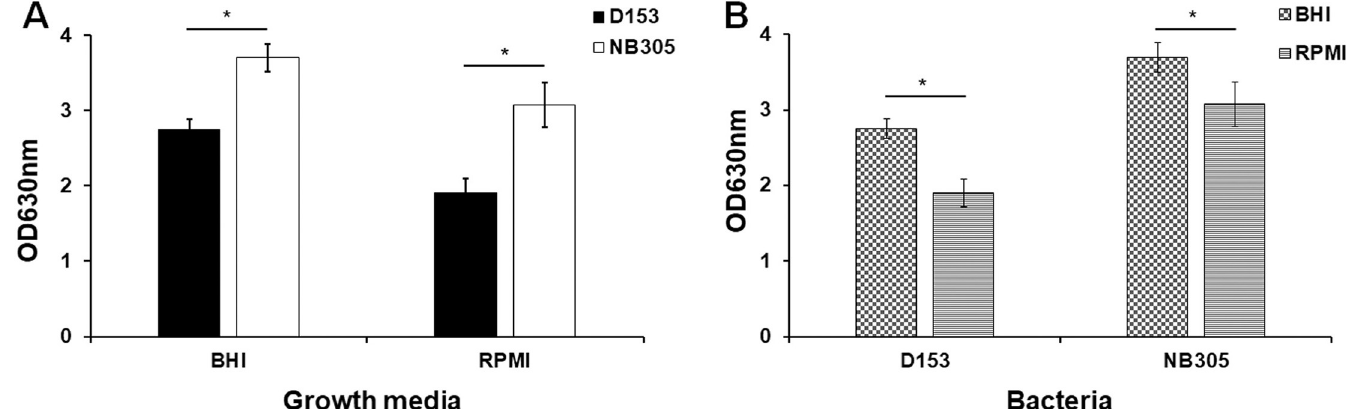
Fig 1. Quantification of total biomass of biofilms. M . haemolytica (D153) and S . aureus Newbould 305 (NB305) were grown in BHI broth and colorless RPMI 1640 in 24-well plates at 37˚C for 48 h (NB305) to 72 h (D153). The effects of growth media (A) and bacteria (B) on the amount of biofilm productions were compared with each other. Biofilms were stained with crystal violet and the absorbance of released crystal violet in glacial acetic acid was measured at 630 nm (OD 630 ). Bars indicate mean and standard deviation of total biomass of biofilms from three independent experiments performed in six replicate wells are shown. Differences between biomass of biofilms were determined by Student’s t -test. � P <